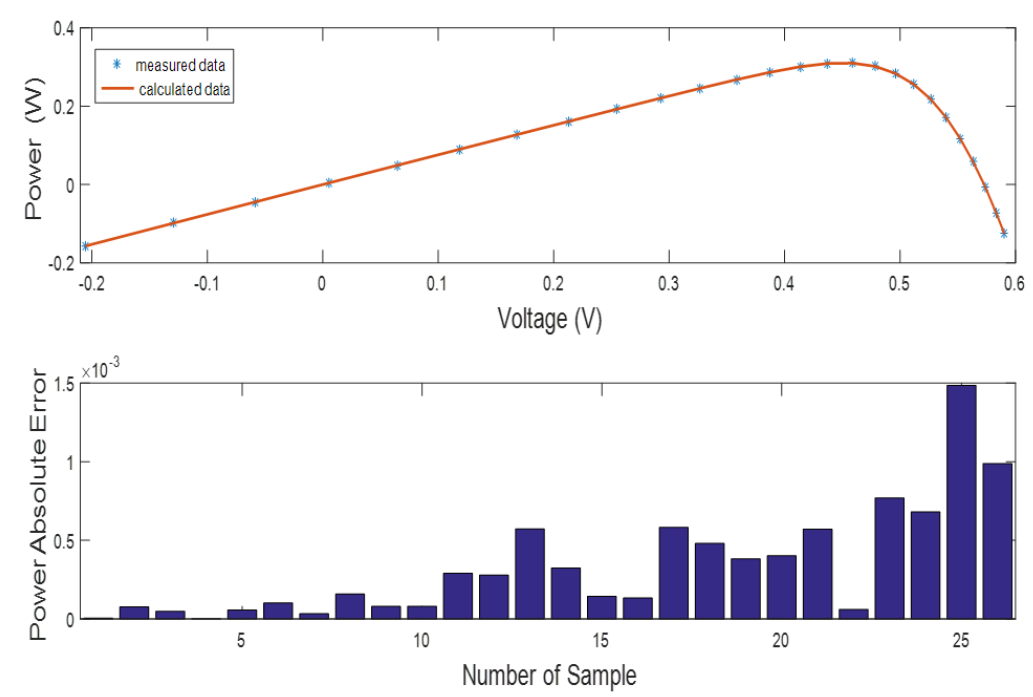
Figure 10. The DDMSC’s P–V curve based on the best solution from the INFO algorithm.